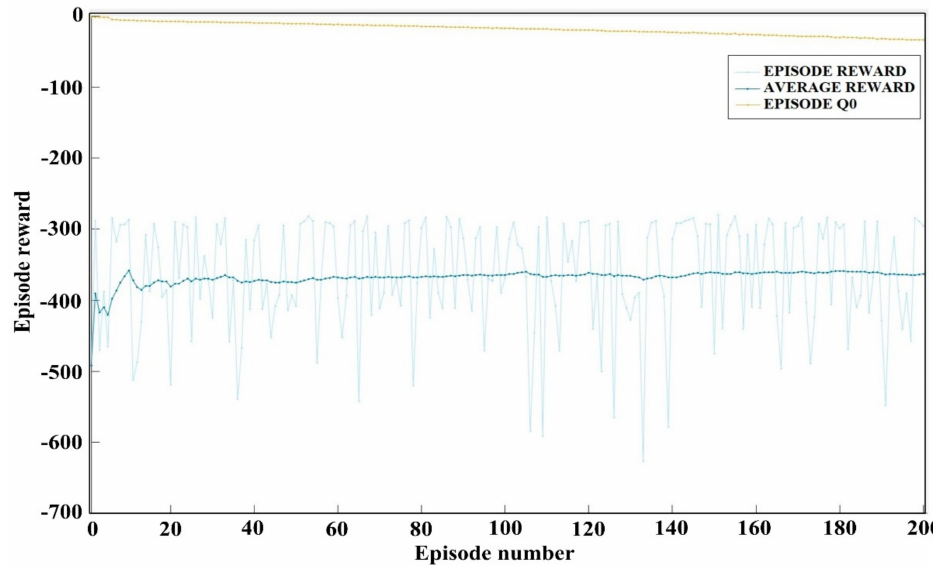
Figure 21. Evolution of the reward for the RL-TD3 agent algorithm’s